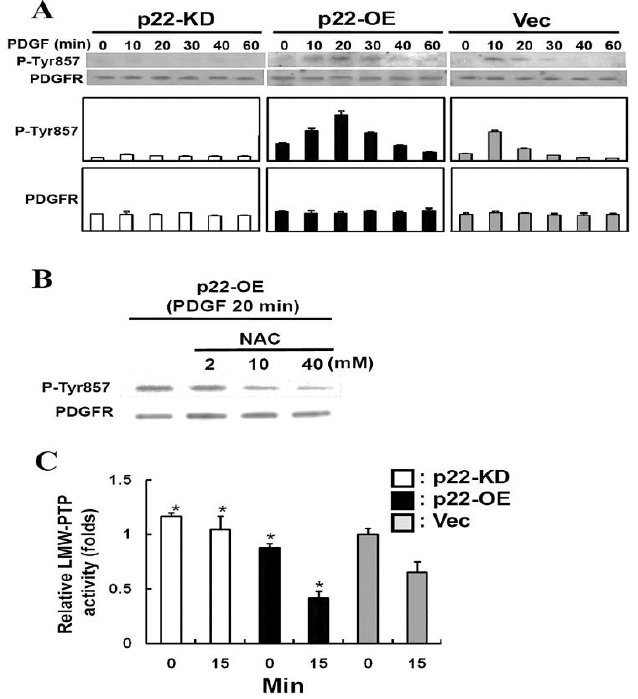
Figure 11. Effect of p22phox expression on the activation of PDGF receptor and LMW-PTP activity induced by PDGF in HLE B3 cells. ( A ) The Western blot analysis of PDGF-activated (phosphorylated) Tyr857 on PDGF receptor of HLE B3 cells. PDGF (20 ng/mL)-stimulated p22-KD, p22-OE, and Vec cells for 0, 10, 20, 30, 40, and 60 min were lysed and immunoblotted for P-Tyr857 PDGF receptor with anti-P-PDGFR antibody. The blot was also reprobed with anti-PDGFR antibody for control. The Western blot analysis is a typical pattern from three independent experiments. ( B ) Inhibition of PDGF-stimulated Tyr857 of PDGFR activation in p22-OE cells by antioxidant NAC. The detection of phosphorylated PDGF at Tyr857 was done by Western blot analysis in p22-OE cells. The p22-OE cells were pretreated with or without NAC for 60 min followed by the treatment of PDGF (20 ng/mL) for 20 min. Each lane contains 25 μg of cell lysate protein. The blot was reprobed with anti -PDGFR antibody as the control. ( C ) Analysis of LMW-PTP activity in PDGF-stimulated p22-KD, p22-OE, and Vec cells. The cells were stimulated with 20 ng/mL of PDGF for 0 and 15 min, and immunopre- cipitated for LMW-PTP using anti-LMW-PTP antibody. Each immunoprecipitant was used for LMW-PTP activity assay. The results are the average of three independent experiments and are ex- pressed as the mean ± SD. * p < 0.05 compared with Vec cells in the same treatment conditions (ANOVA). Reprinted with permission from Wang and Lou, IOVS (2009); Copyright ARVO 2009 [92].